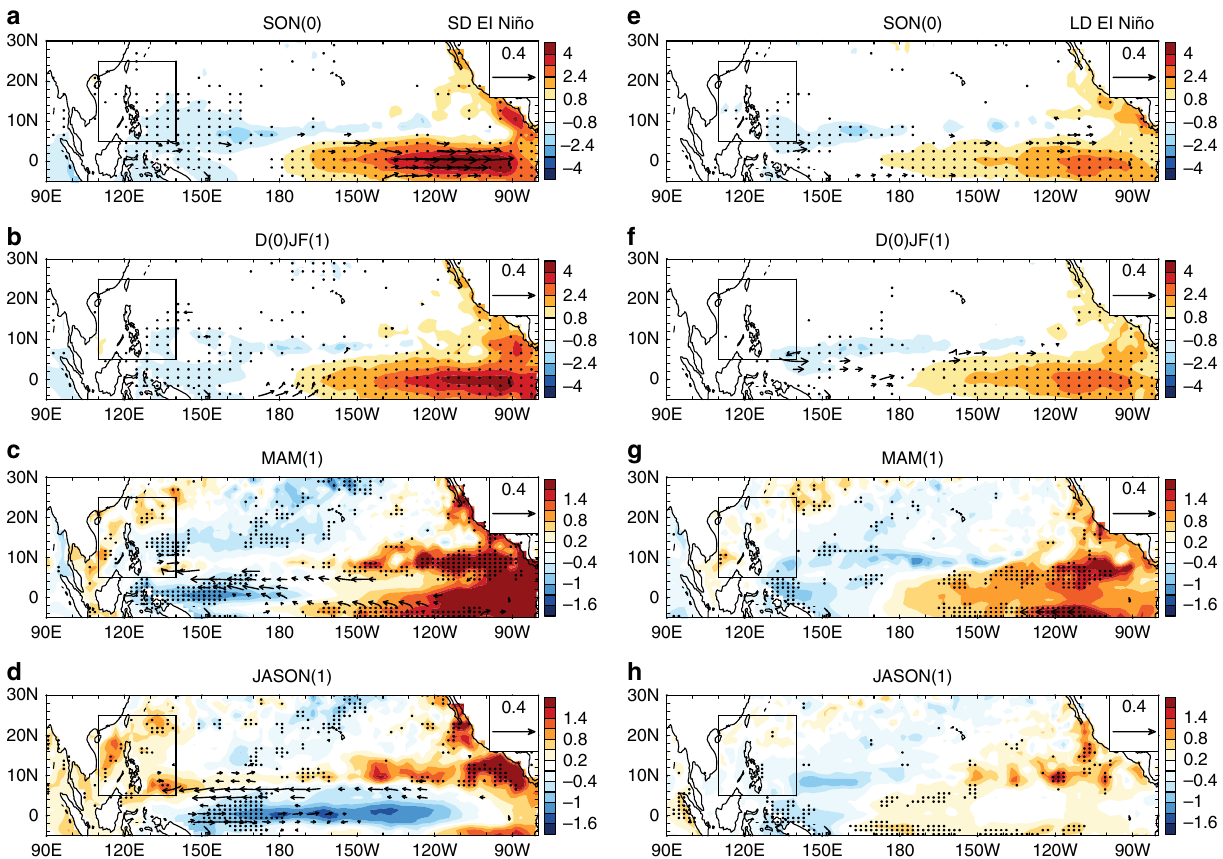
Fig. 4 Evolution of the ocean heat content and upper ocean current for the short duration and long duration El Niño events. Composite anomalies of mean upper ocean (5 – 100 m) temperature (shading, units: K) and currents (vectors, units: m s – 1 ) from SODA reanalysis dataset for a September(0) – November (0), b December(0) – February(1), c March(1) – May(1), and d July(1) – November(1) during short duration El Niño events. e – h as in a – d , but for long duration El Niño events. (0) and (1) indicate the months in El Niño developing and decaying years, respectively. Black boxes indicate the South China Sea and the Western Philippine Sea region. The stippled areas indicate the values are statistically signi fi cant at the 95% con fi dence level. The vectors only show